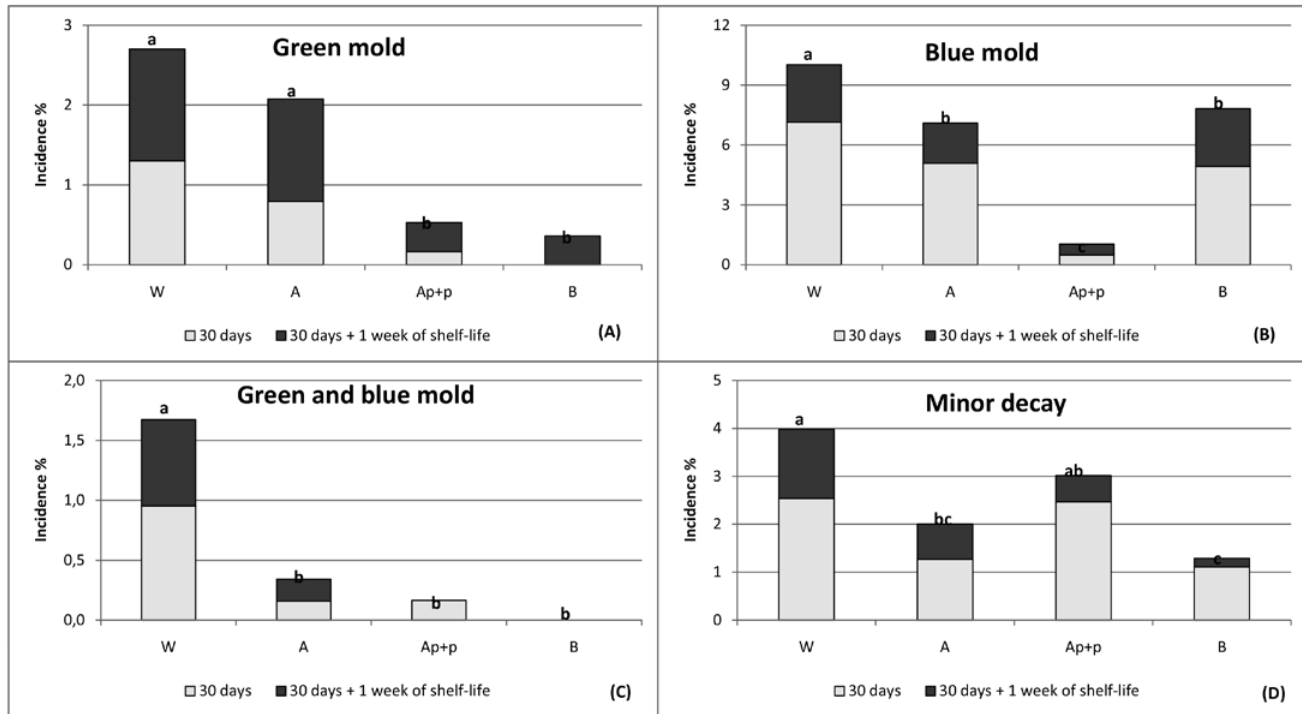
Fig. 1 - Incidence of green mold ( P. digitatum ) (A), blue mold ( P. italicum ) (B), mix of green-blue mold on the same fruit (C) and minor decay (D), on clementine, after 30 days of storage at 6±1°C followed by one week at 20±2°C. Each treatment was applied to three replicates of 200 fruit each. Water treatment was used as control. Columns marked with the same letters are not statistically different according to Tukey’s test (P = 0.05). W= Water control, preharvest treatments; A= Potassium phosphite, preharvest treatments (2.5 g/L); Ap+p= Potassium phosphite, pre- (2.5 g/L) and postharvest treatments (4 g a.i./L); B= Phosetyl-Al, preharvest treatments (2.5